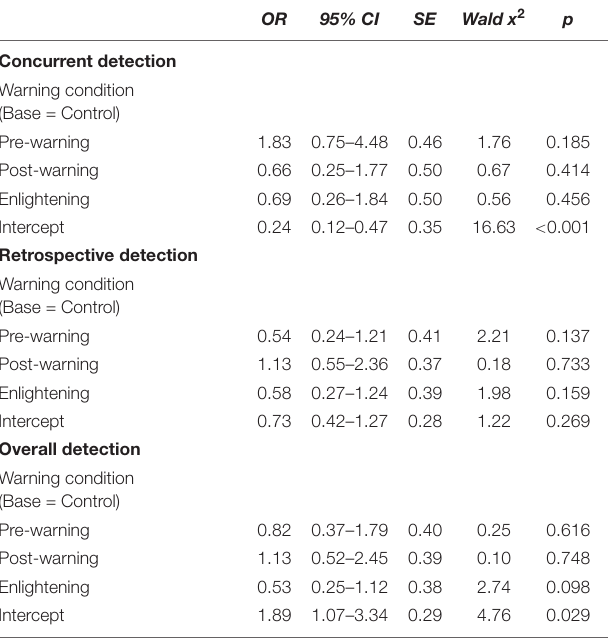
TABLE 2 | Summary of GEE analysis for concurrent, retrospective, and overall TABLE 1 | Summary of GEE analysis for concurrent, retrospective and overall detection rates identification accuracy and lineup selection. detection rates as a function of warning condition. OR 95% CI SE Wald x 2